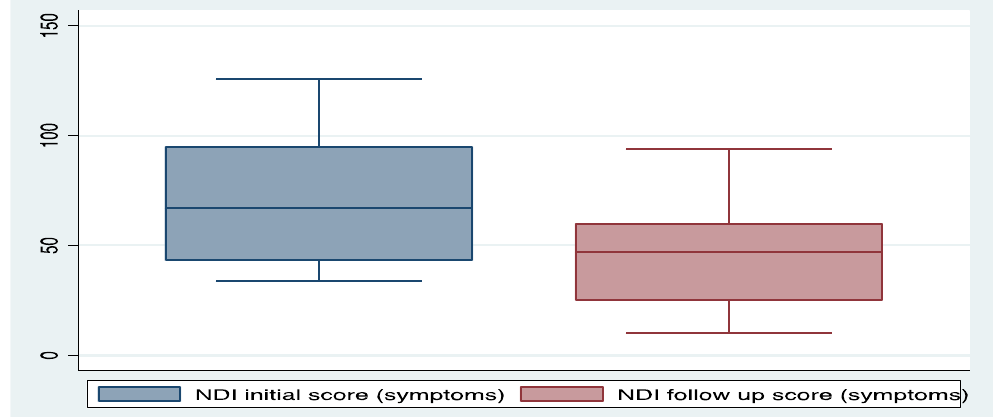
Figure 4. Mean symptom scores before (n = 10) and after (n = 8) the gluten-free, low-FODMAP diet ( p = 0.087, Wilcoxon sign rank test). NDI—Nepean dyspepsia index. Nutrients 2020 , 12 , 1947